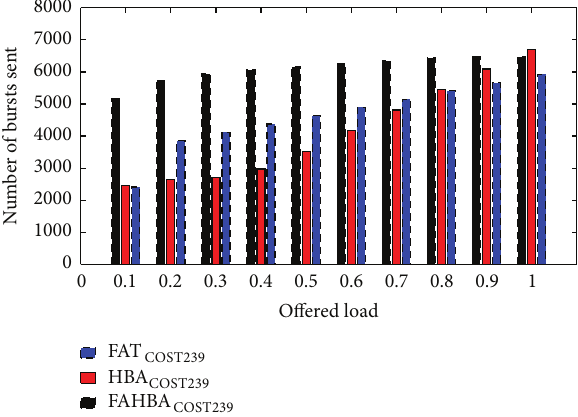
Figure 4: Burst end-to-end delay versus offered load.